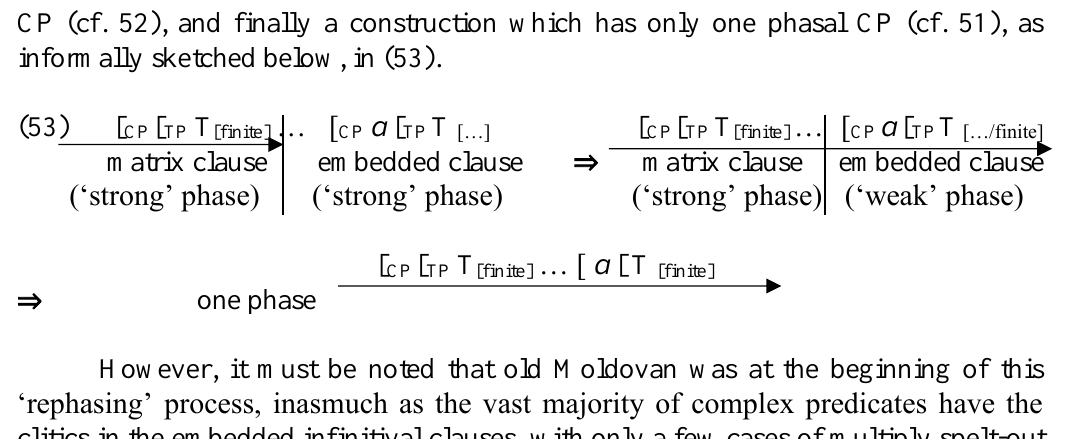
functional verbs with multiple spelt out clitics 1 0